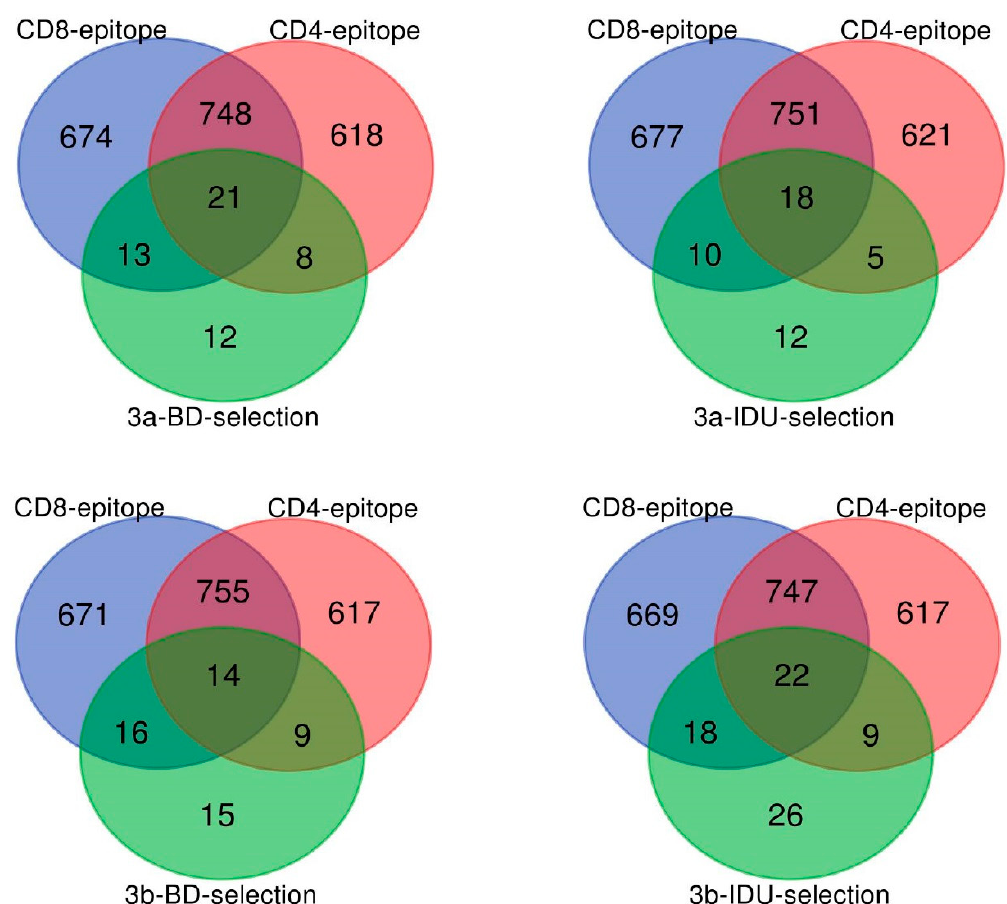
Figure 7. Venn diagrams for the overlap of the CD8/4 epitopes with the selection in HCV GT-3a-BDs, GT-3a-IDUs, GT-3b-BDs4, and GT-3b-IDUs.